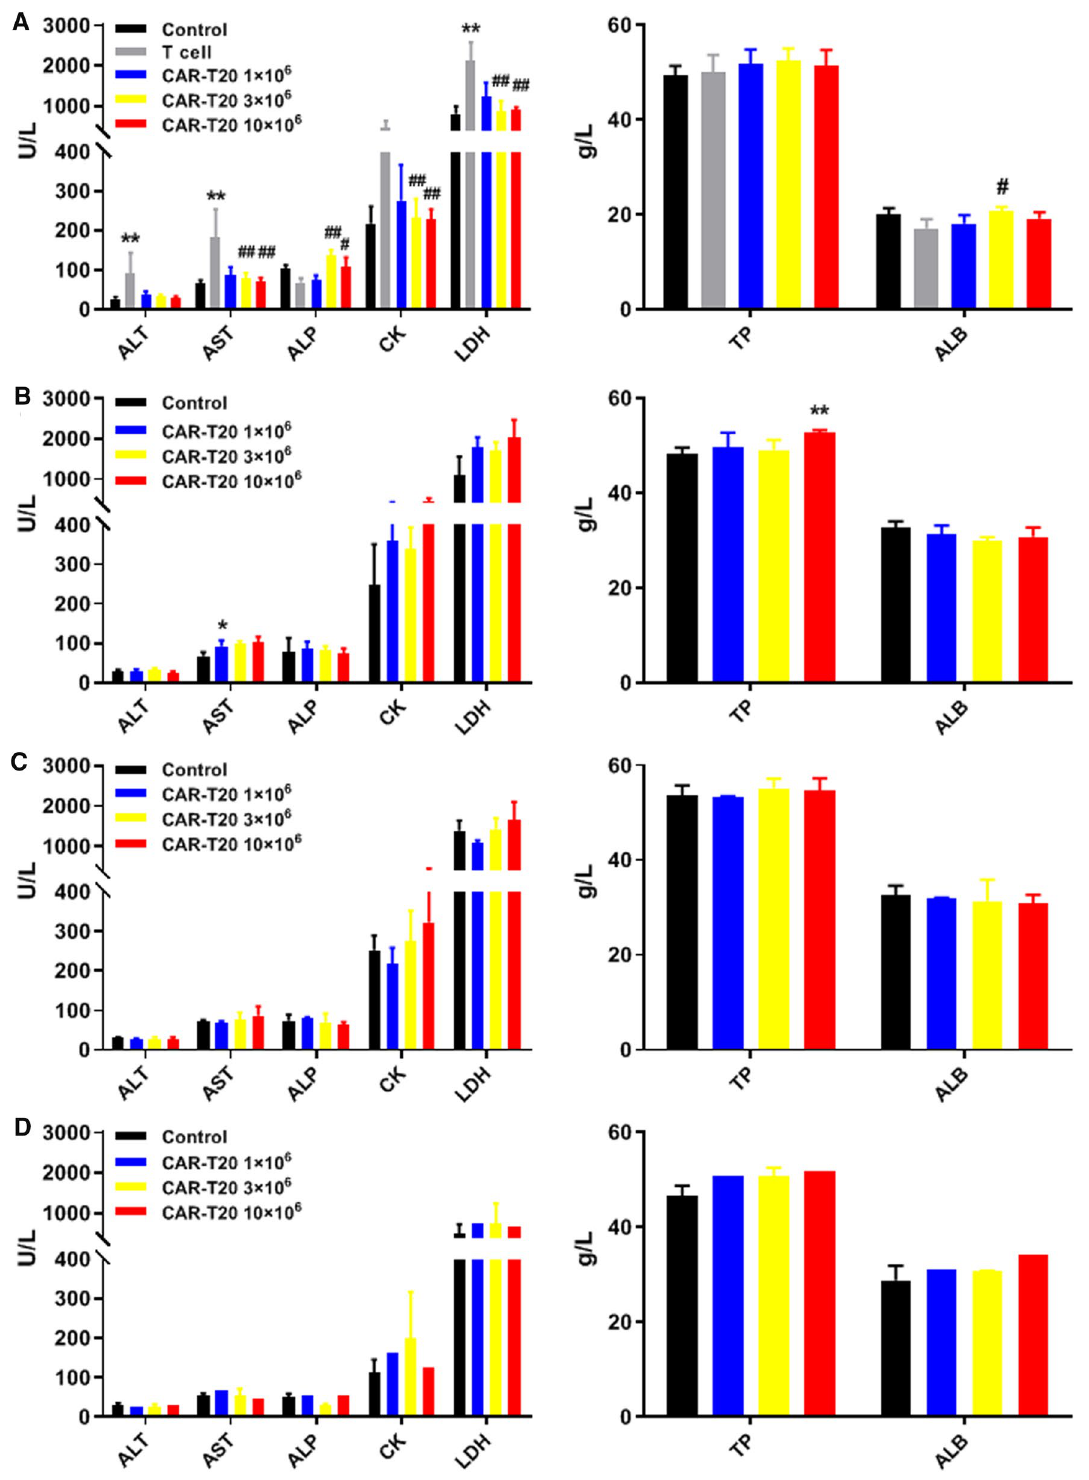
Fig. 6 Effects of CAR-T20 on serum biochemistry indexes. The values ALT, AST, ALP, CK, LDH, TP and ALB at 14 days ( A ), 28 days ( B ), 56 days( C ) and 90 days ( D ) after administration were shown. CAR-T20 mitigated the effects of Raji-Luc cells on liver function in mice and improved the malnutrition due to tumor burden. Data are shown as the mean ± SD (n = 6). Comparing with the Buffer group, *p < 0.05, **p < 0.01; comparing with the T cell group, #p < 0.05, ##p <